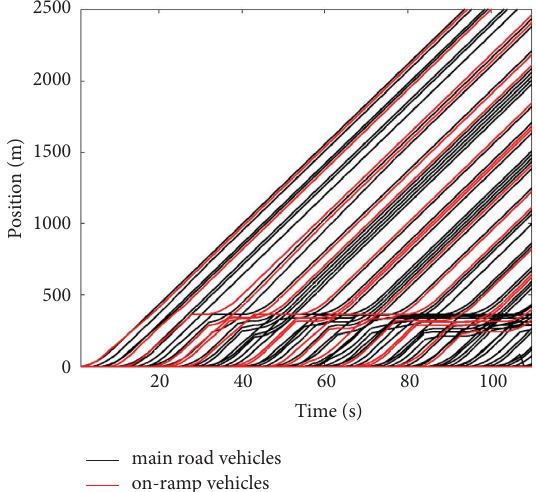
Figure 13: Vehicle trajectory line without guiding.